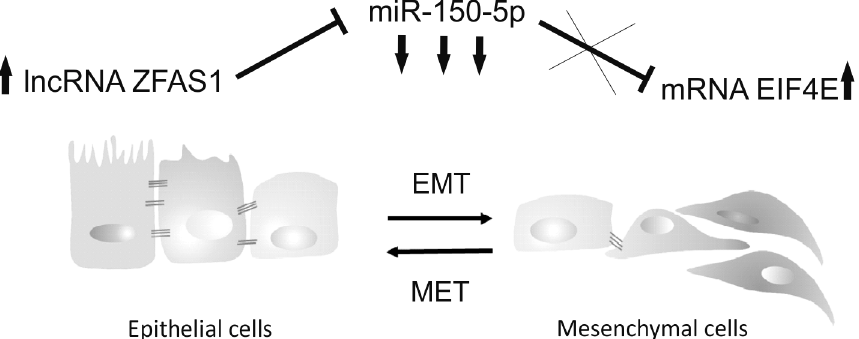
Figure 6. The proposed mechanism of the oncogenic role of lncRNA ZFAS1 in HNSCC. ZFAS1 acts as a molecular sponge and down-regulates abundance of miR-150-5p . The low level of suppressor miR-150-5p causes up-regulation of oncogenic targets such as EIF4E , which in turn up-regulates expression of genes connected with EMT, metastasis and poor patient outcome.